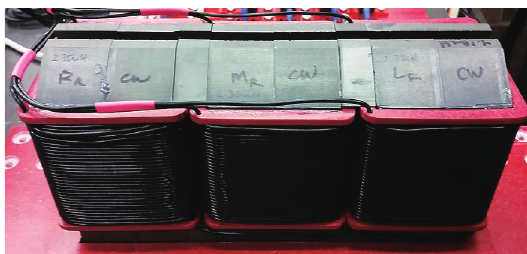
Fig. 4 Circuit diagram of the EDX drive